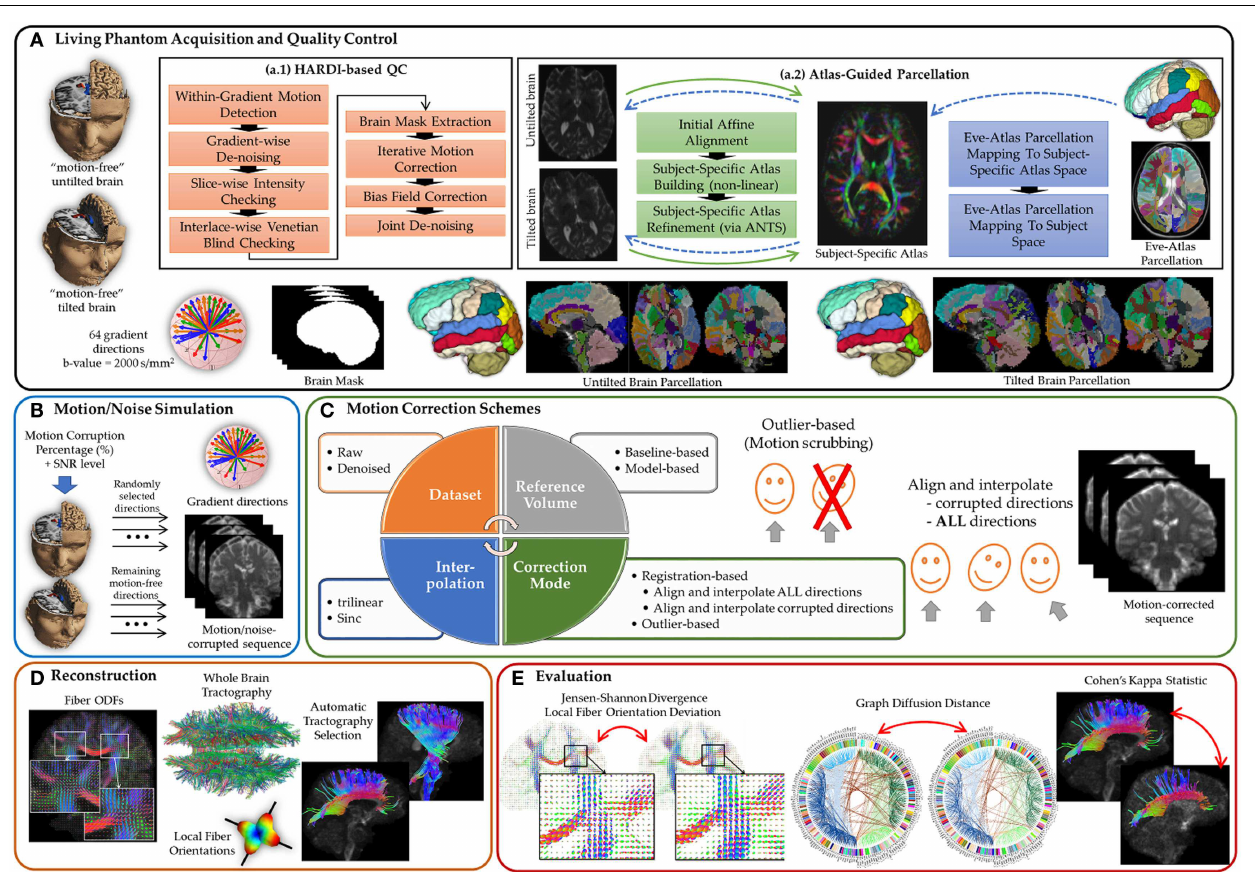
FIGURE 1 |A comprehensive experimental framework for subject motion simulation to systematically evaluate the outcome of different motion correction choices commonly used by the scientific community on HARDI-based reconstructions and tractography . (A) A human brain HARDI data were acquired from a well-controlled motion experiment. (a.1) Acquired DWIs were preprocessed to obtain nearly noise-free and motion-free datasets. (a.2) For automated tractography selection and the quantification of whole brain connectivity, a subject-specific unbiased atlas was constructed via DTI-derived data from HARDI sequences resulting in a tensor atlas, where we can define a detailed parcelation of neuroanatomical structures, and map it back to each raw scan. (B) Noticeable motion was then simulated by randomly mixing gradients from the acquired datasets. (C) Motion correction involves four main decision variables where each distinct combination of choices defines a correction scheme. (D) Reconstruction of a corrected or motion-free dataset entails reconstructing the voxel-wise fiber orientation distribution functions, detecting local (voxel-wise) fiber orientation, preforming whole brain tractography, and automatically selecting anatomical pathways. (E) The evaluation of the effect of a motion correct scheme has been investigated based on voxel-wise metrics, global brain connectivity metric, and tract-based